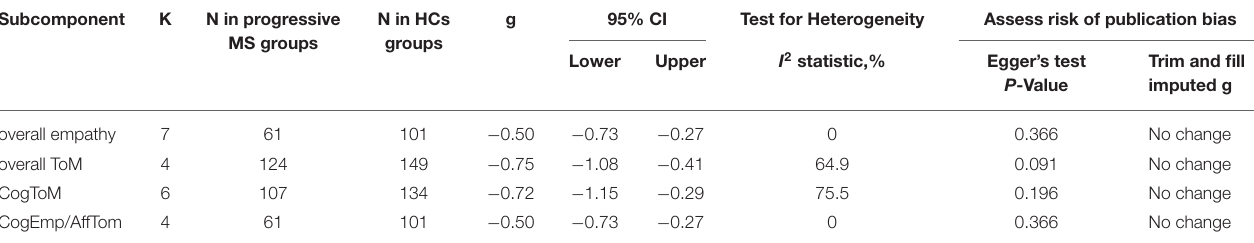
TABLE 5 | Mean effects for ToM and empathy subcomponents comparing participants with progressive multiple sclerosis against healthy controls and tests for publication bias. Subcomponent